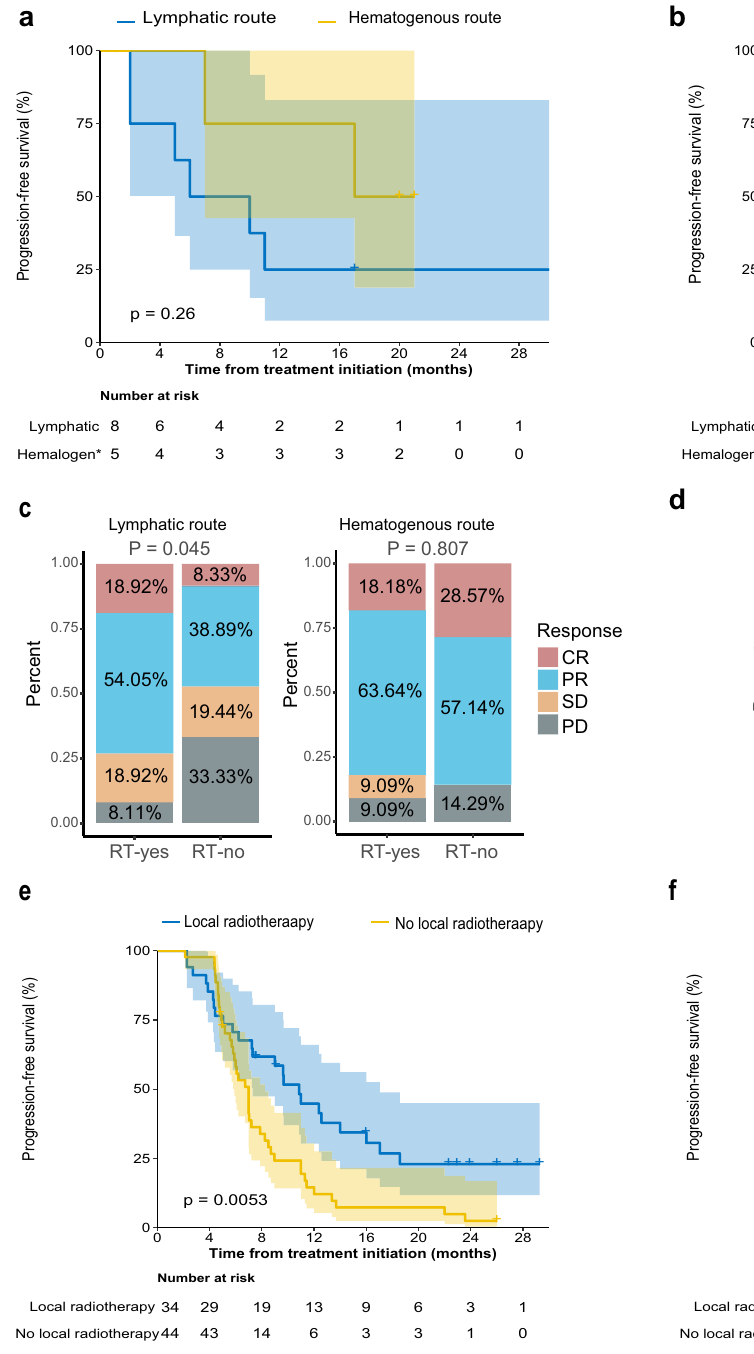
Fig. 7 | Different clinical outcomes between the “ lymphatic ” and “ hemato- genous ” metastatic routes. a Kaplan ‒ Meier curves of progression free survival (PFS) in the 13 NPC with identi fi ed metastatic models via genomic phylogenetic tree.Thedataareshownalongwith95%con fi denceintervals.Thelog-ranktestwas used to calculate the P value (two-sided). b Kaplan ‒ Meier curves ofPFScomparing theradiomics-predictedlymphaticandhematogenousmetastaticmodelsinthede novo metastatic NPC cohort. The data are shown along with 95% con fi dence intervals.Thelog-rank testwasusedto calculate the P value (two-sided). c Bar plot showing the different treatment response rates between patients who received